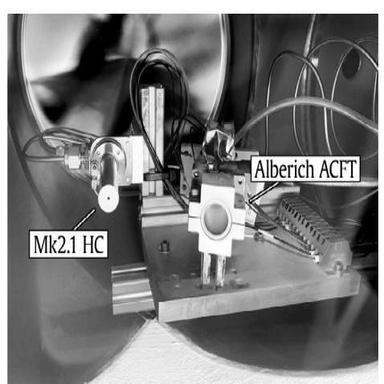
Endurance test setup within the 40-l vacuum chamber. The Alberich ACFT is displayed on the right, while the hollow cathode MK 2.1 is on the left.